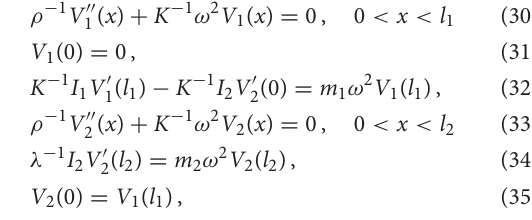
FIGURE 9 | Modification of the gap width and position with respect to the radius of the thin channel of the Helmholtz resonator with a single shell like in Figure 3 . The eigenfrequency estimates ω 1 compare well with finite element results ω ∗ 1 r 0.01m, see Table 1 . Note the non linear scale for r =